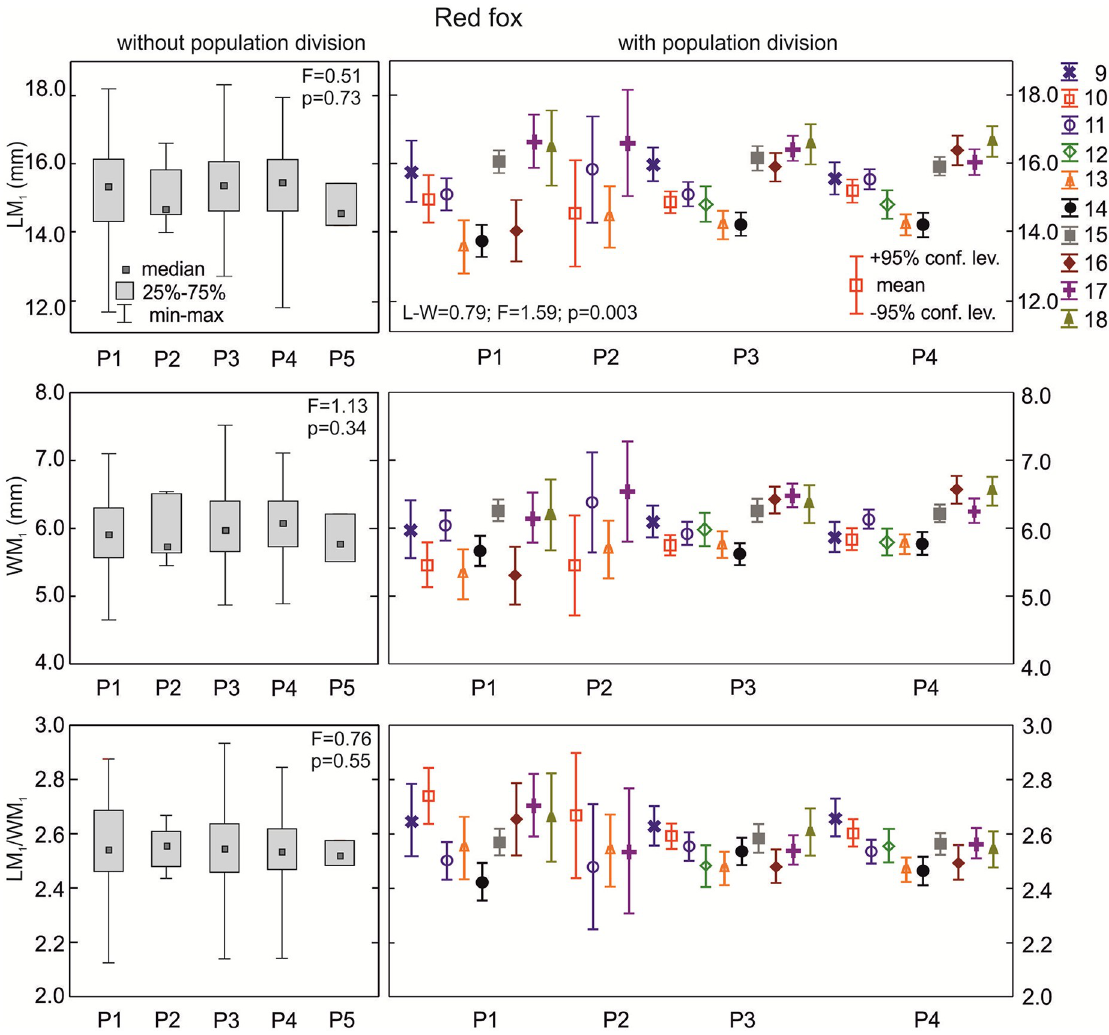
Fig 10. Comparison of median values for length, width, and size proportion of M 1 between various group P morphotypes in the red fox with and without population division. Illustrations of P group morphotypes are shown in Fig 2. Information about the samples can be found in Table